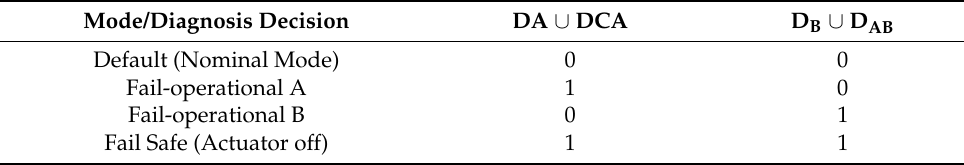
Table 8. Mode transition management based on diagnosis decision